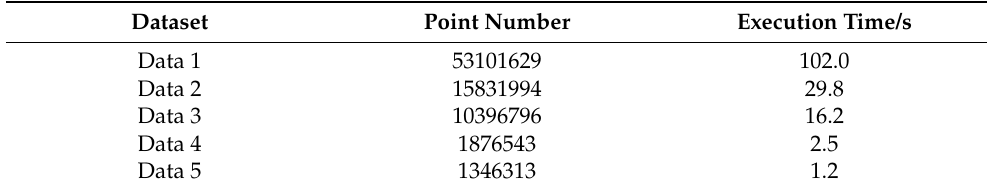
Table 6. Running time on each dataset ( N = 500 and K =